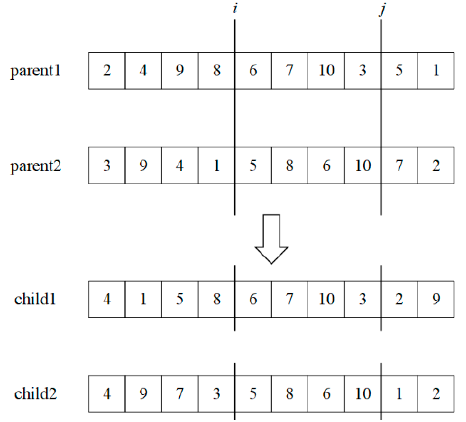
Figure 5. An instance of the crossover operation.